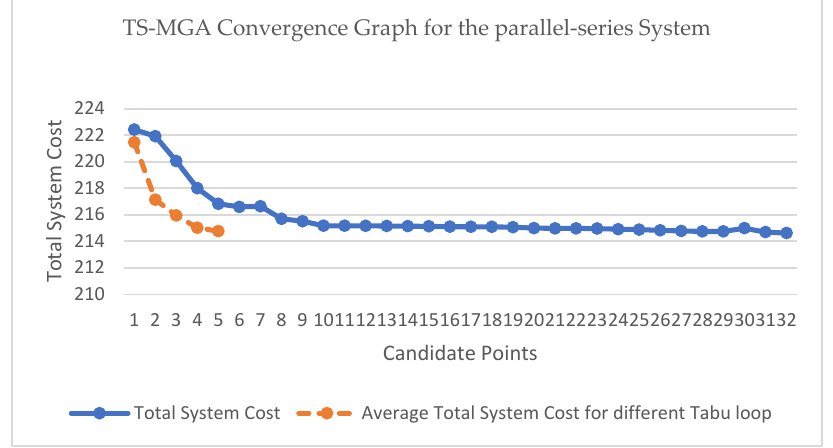
Figure 9. The convergence graph of the parallel-series system by implementing the TS-MGA com- bined method.